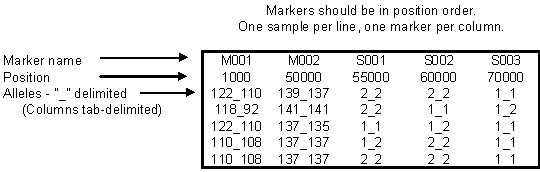
The format of a MIDAS input file. Data are raw genotypes in a tab-delimited text file. Row 1 contains marker names, row 2 contains positions. Markers should be sorted in position order for clarity. Alleles should be delimited by an underscore ("_"), and can be any valid letter or number. Where numbers are used, ensure that the same number of digits are used for all alleles (eg 094, 098, 102) to preserve size order in the alphanumeric sort. There must be no more than one blank line at the end of the data and all null values must be coded as "?_?".